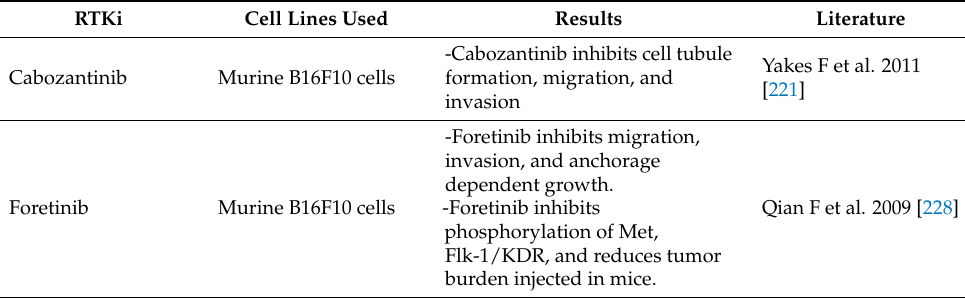
Table 12. Dual VEGFR/MET inhibition in melanoma preclinical studies.